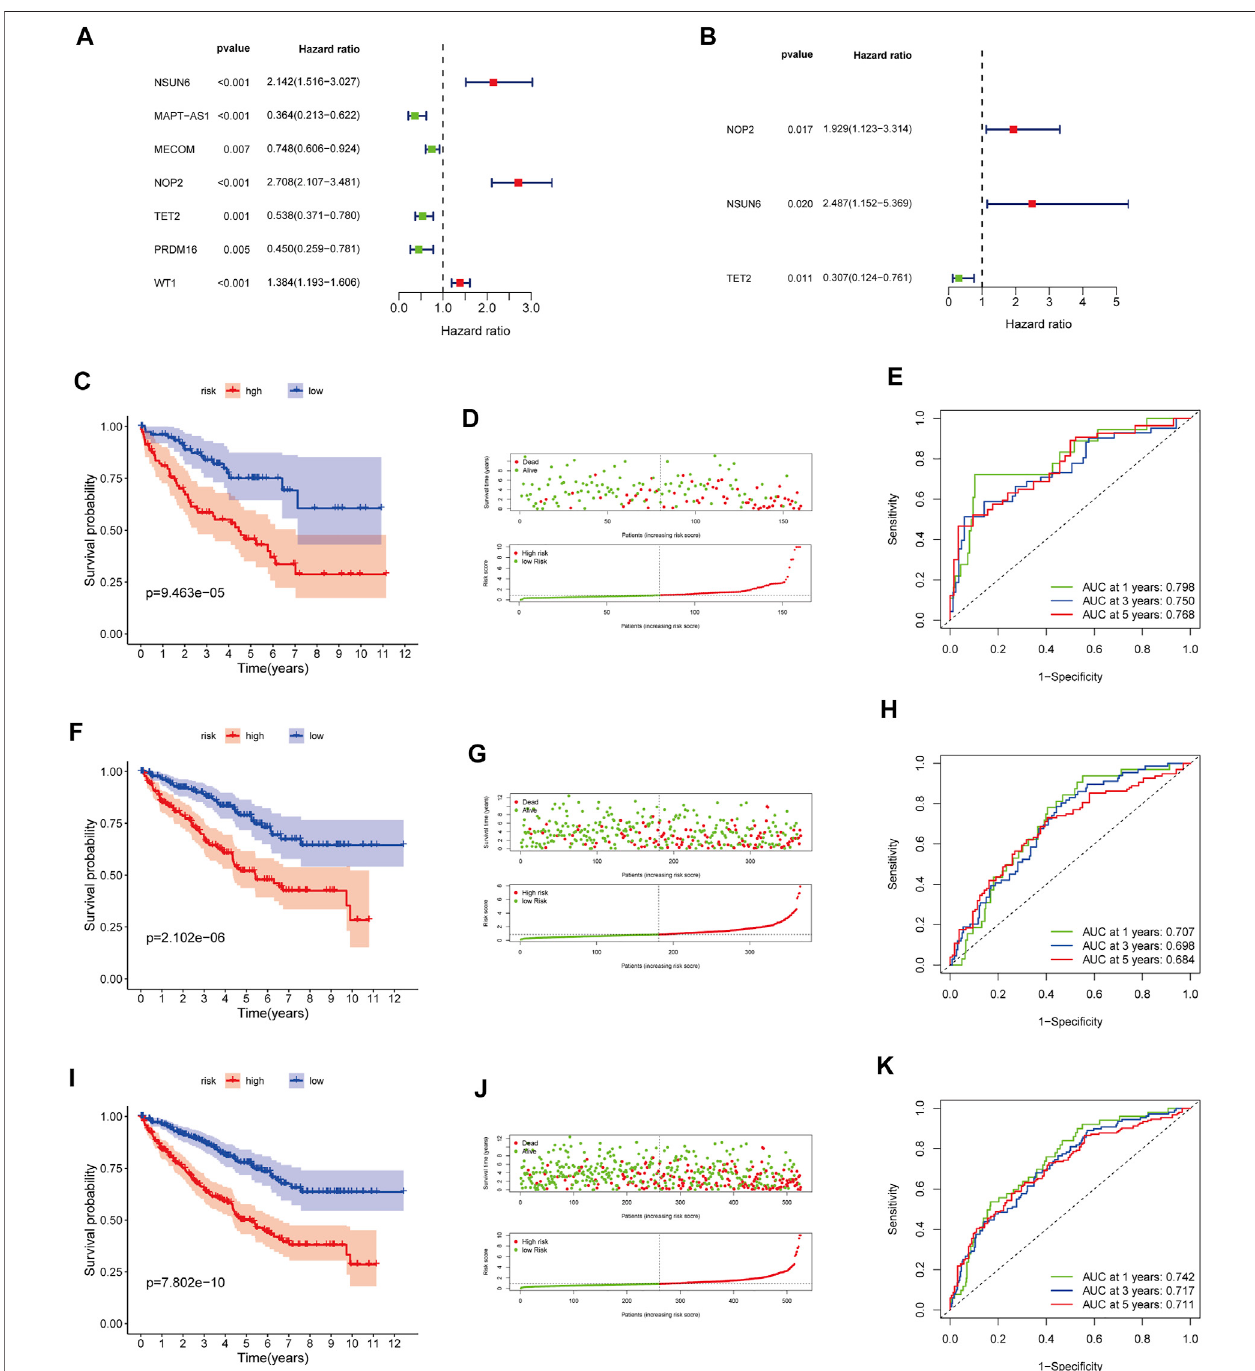
FIGURE 4 | Construction and validation of the MRGPS. (A) Forrest plot of the univariate Cox regression analysis in the training cohort. (B) Forrest plot of the multivariateCoxregressionanalysisinthetrainingcohort.Kaplan-Meieranalysis,riskscoreanalysisandROCcurveoftheMRGPSinthetrainingcohort (C – E) ,validation cohort (F – H) , and whole TCGA cohort (I – K)